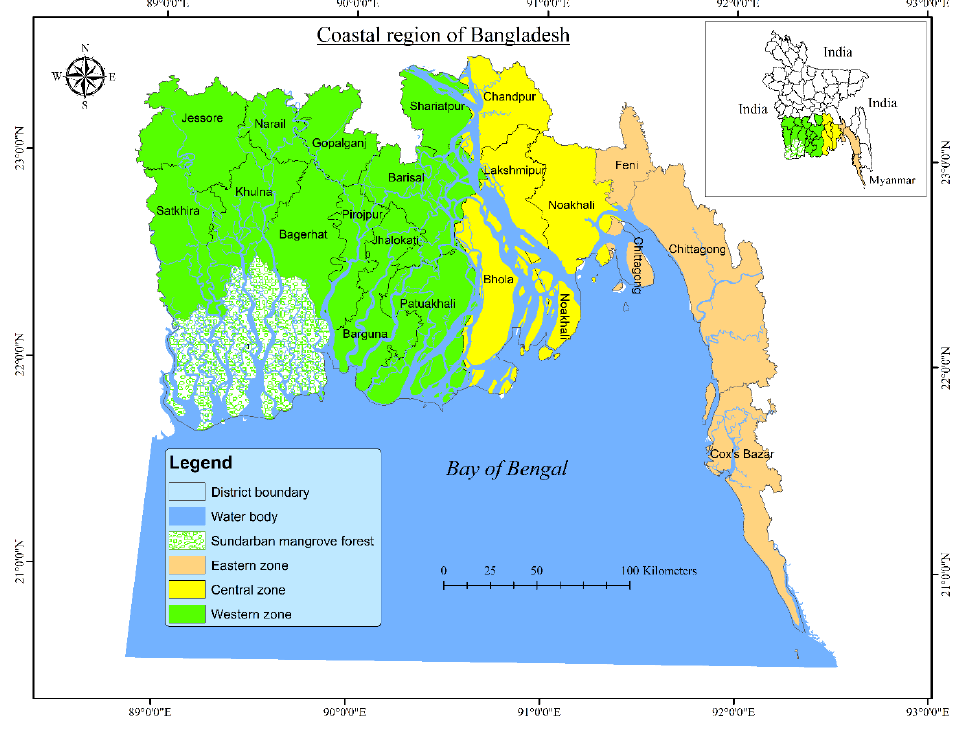
Figure 1. Study location